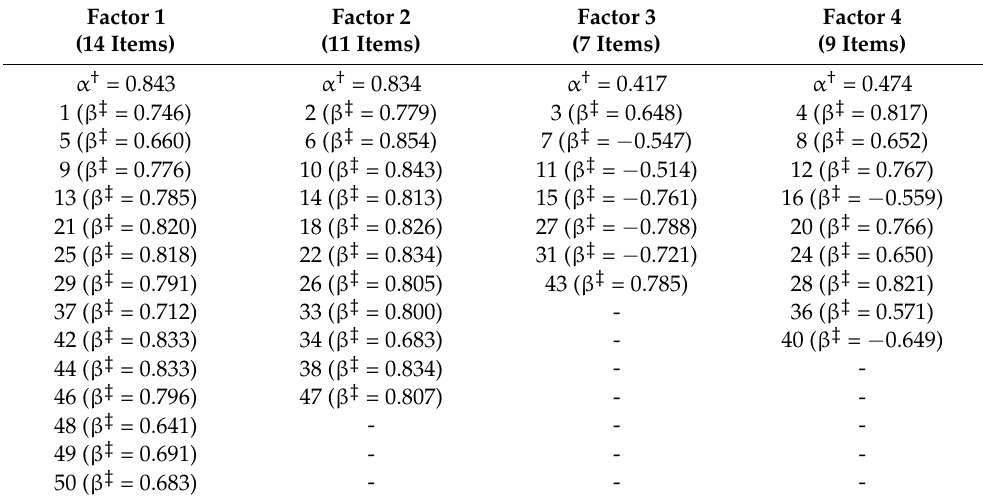
Table 1. Standardized factor weights of the 41 items of the scale obtained through the confirmatory factor analysis and Cronbach’s alpha, in the 4 factors (n* = 500).